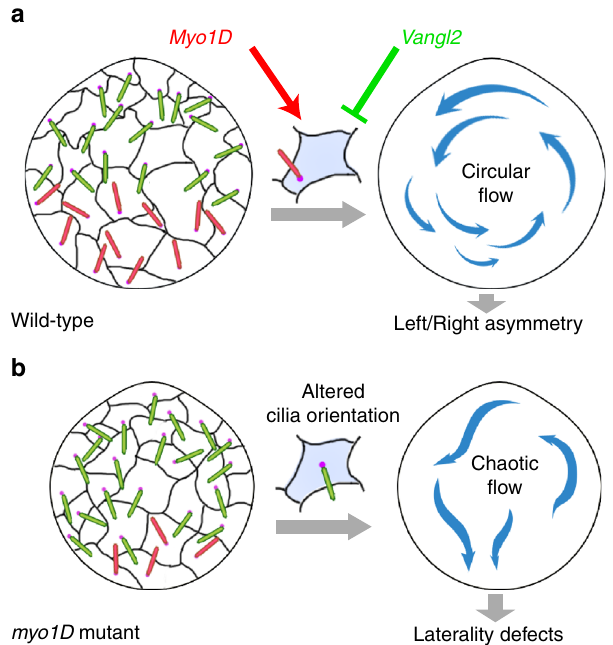
Fig. 7 Model of Myo1D function in the zebra fi sh left – right organizer. a Schematic representation of a wild-type Kupffer ’ s vesicle (KV). Black lines indicate cell outlines and dots in magenta the basal bodies of KV cilia. Cilia pointing to the posterior are indicated in green, anteriorly pointing cilia in red. Under wild-type conditions Myo1D and Vangl2 exert opposing activities on cilia orientation, restricting thereby posteriorly pointing cilia to the anterior KV and anteriorly pointing cilia to the posterior KV. This control of cilia orientation allows the generation of a circular counter- clockwise fl uid fl ow that promotes a proper establishment of left – right asymmetry at the level of different organs. b In myo1D mutant embryos, cilia orientation is altered so that posteriorly pointing cilia now invade the posterior KV. The KV fl ow loses its circular geometry and becomes chaotic, causing thereby the occurrence of subsequent morphological laterality defects at the level of the heart, viscera, and